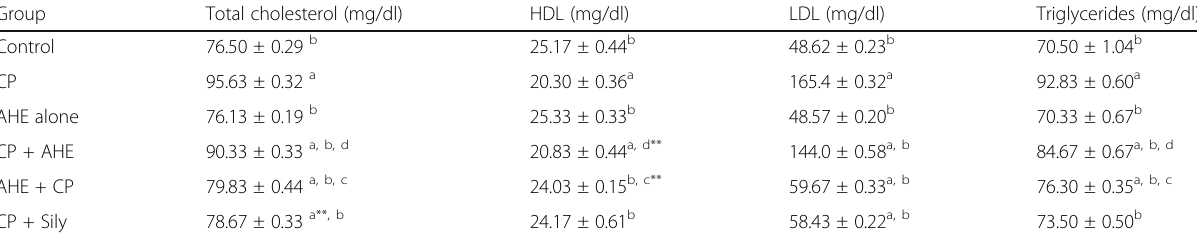
Table 1 Effect of cisplatin (CP) and different treatments of AHE on lipid profile Group